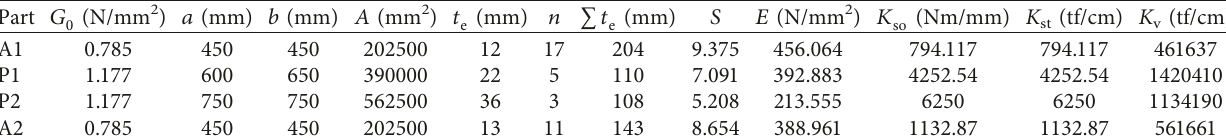
Table 2: Properties of the rubber bearings and spring stiffnesses.